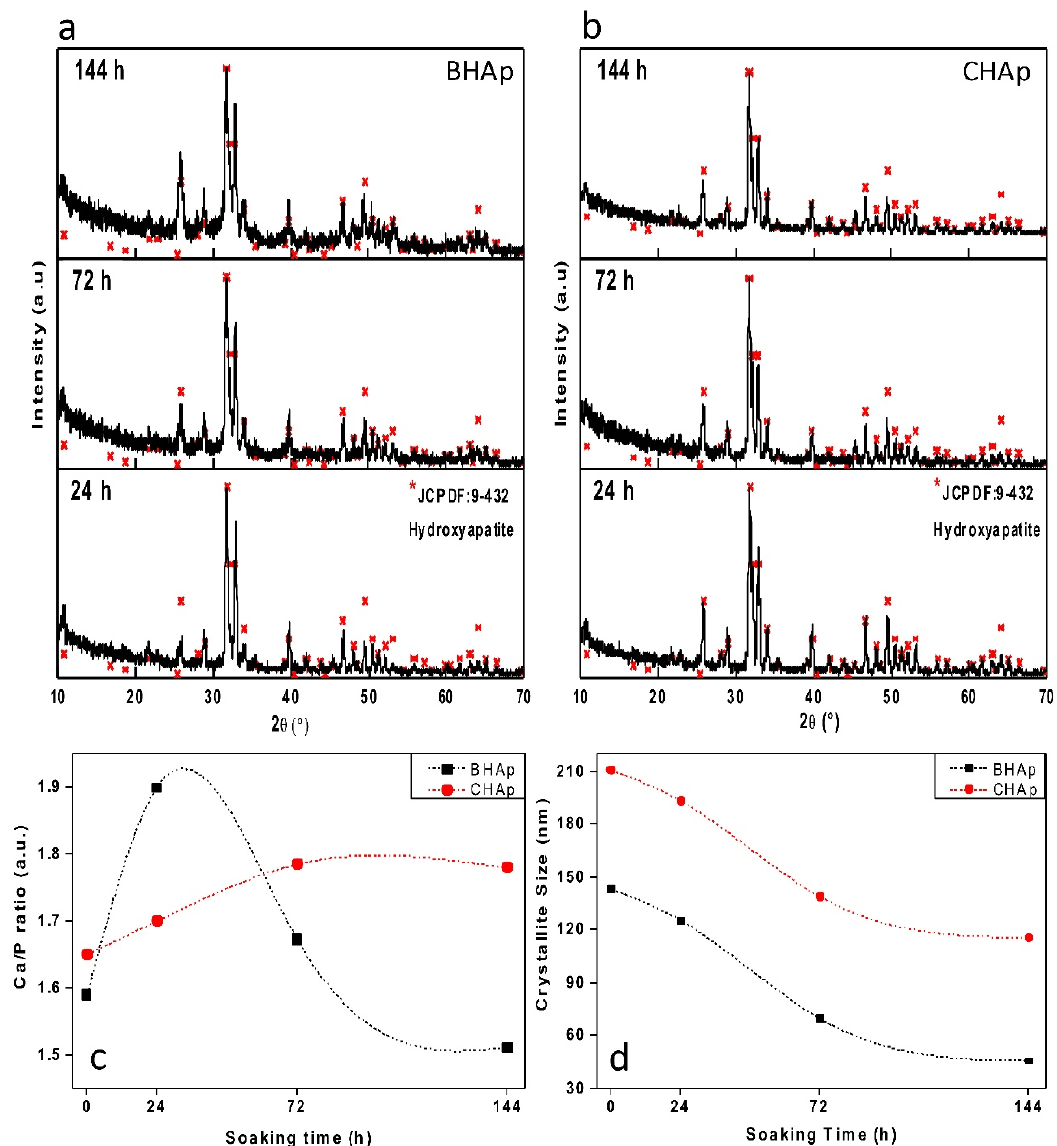
Figure 6. XRD patterns for bovine-derived ( a ) and synthetic ( b ) HAp sintered ceramics at 1200 °C for 4 h after 24 h, 72 h and 144 h of exposure to simulated body fluid. Changes in Ca / P ratio ( c ) and crystallite size ( d ) obtained by Rietveld refinements.